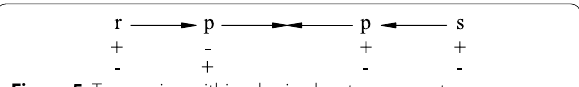
Figure 5 Torque sign within a basic planetary gear